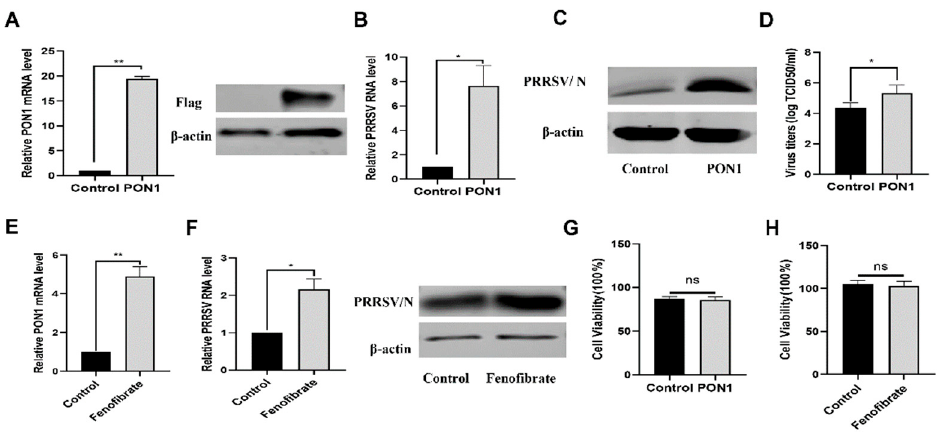
Figure 2. PON1 facilitates PRRSV proliferation. ( A ) Verification of PON1 overexpression. The PON1 in PAMs was mediated by lentivirus for 24 h; then, cell lysates were subjected to qPCR and Western blotting. ( B – D ) The overexpression of PON1 increases PRRSV replication. After the overexpression of PON1 for 24 h, PAMs were exposed to PRRSV for 24 h. The levels of viral RNA were determined by qPCR ( B ), viral protein levels were determined by Western blotting ( C ), and virus titers were detected by TCID 50 ( D ). ( E ) PON1 is activated by fenofibrate in PAMs. PAMs were treated with 40 µ M fenofibrate for 24 h, and the mRNA levels of PON1 were determined by qPCR. ( F ) Fenofibrate facilitates PRRSV proliferation. After being treated with 40 µ M fenofibrate for 24 h, PAMs were exposed to PRRSV for 24 h. The levels of viral RNA were determined by qPCR, the levels of viral protein were determined by Western blotting ( F ). ( G , H ) In PAMs, no toxicity was observed from overexpressed PON1 and fenofibrate. PAMs were treated with either lentivirus-mediated PON1 overexpression or 40 µ M fenofibrate. After 24 h, a CCK-8 assay was performed. Data are presented as the mean ± SD. ns, p > 0.05; *, p < 0.05; **, p < 0.01. The p value was calculated using a Student’s t -test